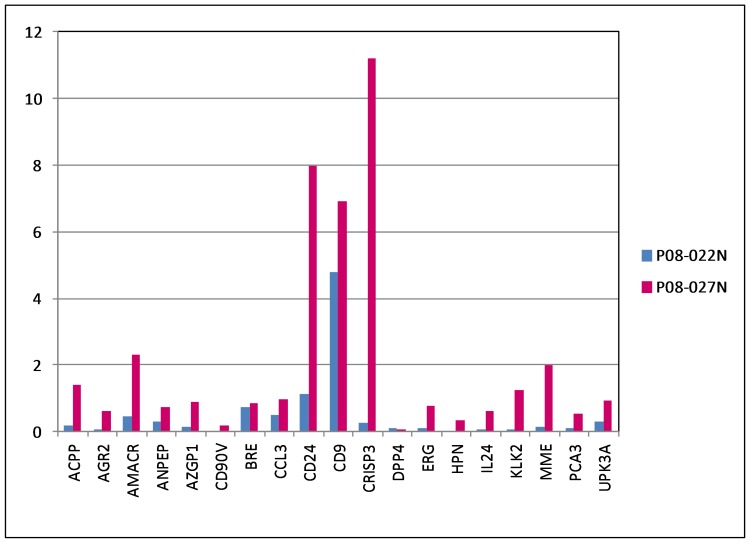
Urine RNA signatures of non-cancer.The histogram data display shows the signal counts for P08-022N (blue) and P08-027N (magenta). The high counts of B2M were excluded for data display. P08-022N shows no signals for the cancer markers. In contrast, P08-027N shows counts for these markers.